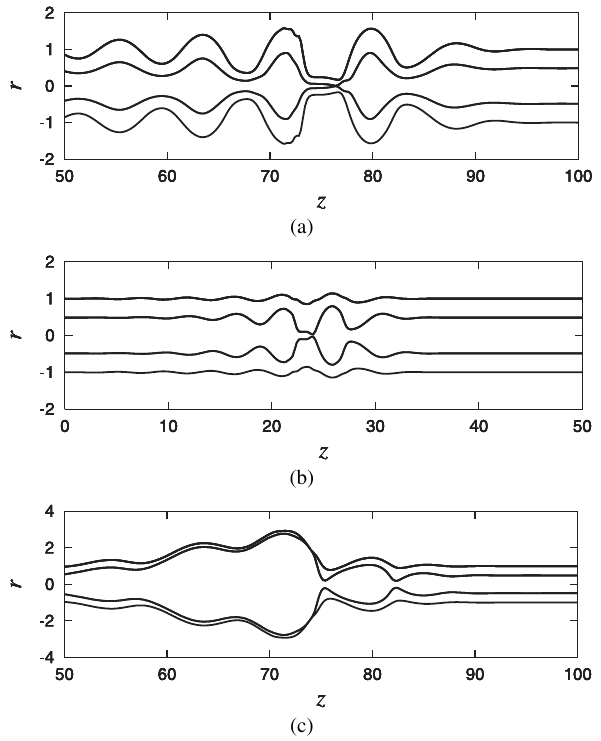
Fig. 2 Typical breakup profiles, where the basic parameters are taken in (b), while in (a) except for σ = 0 . 1 and in (c) except for Re = 10.